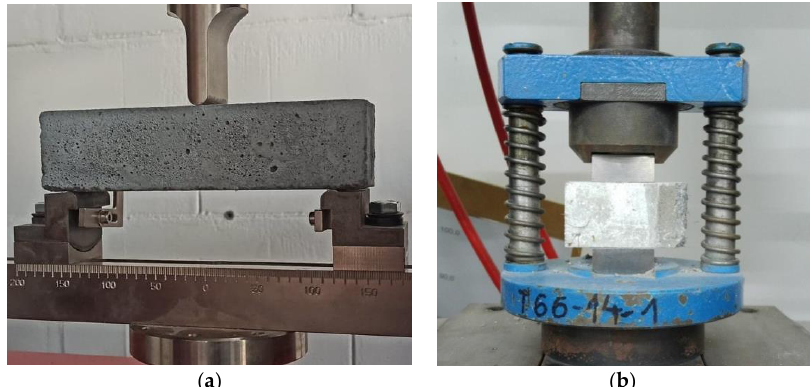
Figure 7. ( a ) Flexural strength and ( b ) compressive strength tests.